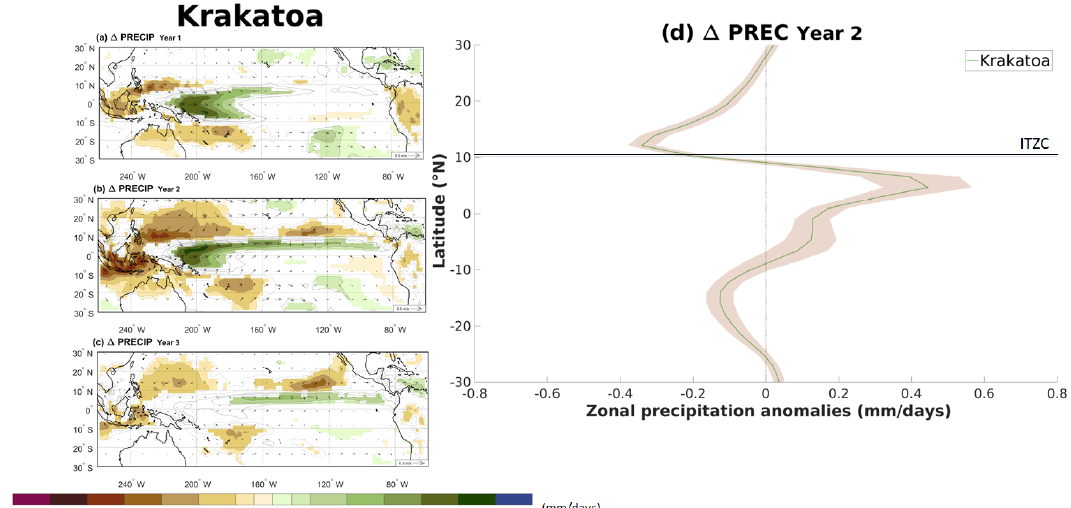
Figure A8. (a, b, c) Ensemble mean of changes in precipitation and 10m wind (arrows) between the 3-year climatology and the volcano case for the three summer-to-winter seasons (June to February) following the Krakatau eruption. Only precipitation changes that are significant at the 95% confidence level using Student’s t test are shaded. Contours show the precipitation anomaly following the colour bar scale (solid lines for positive anomalies and dashed lines for negative anomalies; the 0 line is omitted). (d) Ensemble average of the zonal precipitation anomaly over the Pacific Ocean (160 ◦ E–100 ◦ W) between the 3-year climatology and the summer-to-winter season (June to February) of the second year after the Krakatau eruption. Shading represents twice the standard error of the ensemble mean (i.e. ∼ 95% confidence interval). The blue line highlights the ensemble-averaged 3-year climatology position of the ITCZ (defined as the location of the zonal- average precipitation